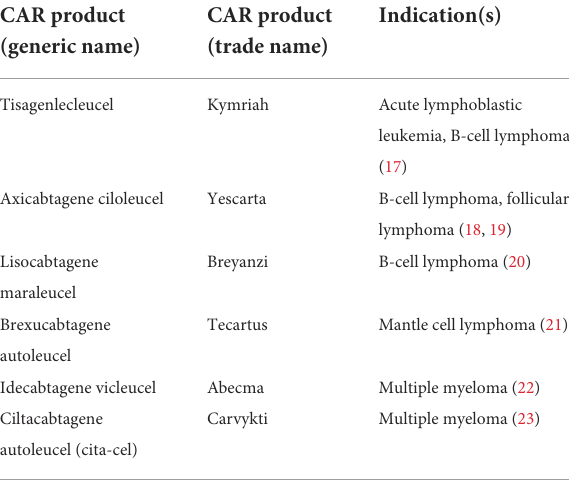
TABLE 1 Summary of current FDA-approved CAR T generic names, trade names, and